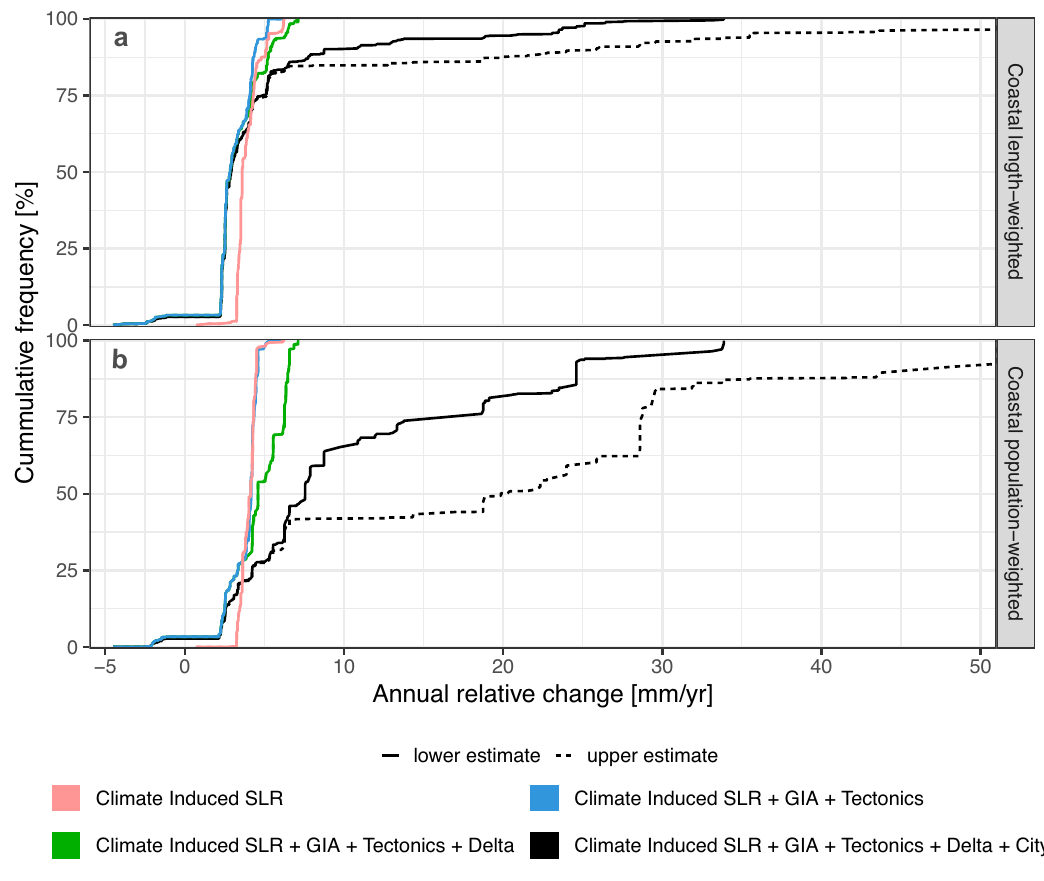
Fig. 2 | Cumulative distribution of contemporary coastal relative SLR (for the year of 2015). a Length-weighted, b Population-weighted. Each panel shows climate-induced SLR alone, and then progressively adds the other RSLR compo- nents comprising: (1) GIA and tectonics, (2) GIA, tectonics and delta subsidence